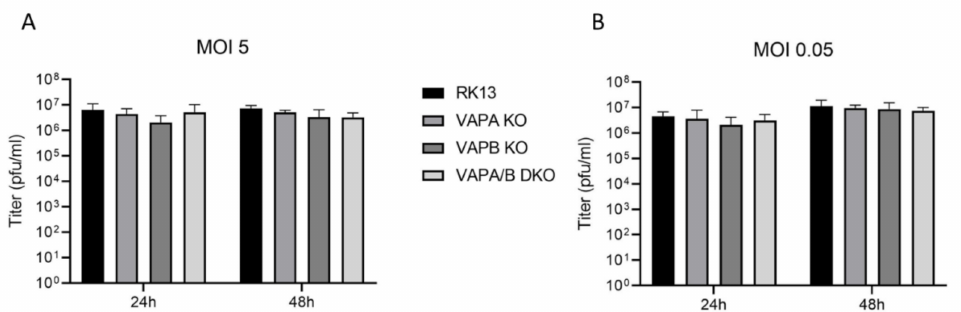
Figure 4. Growth properties of PrV-Ka derived from parental RK13, VAP single and double KO cells. RK13, RK13-VAPA KO, RK13-VAPB KO and RK13-VAPA/B DKO were infected with PrV-Ka at an MOI of 5 ( A ) or 0.05 ( B ) and harvested after 24 or 48 h. Shown are mean values of progeny virus titers in plaque forming units per milliliter (pfu/ml) of five replicates with the corresponding standard